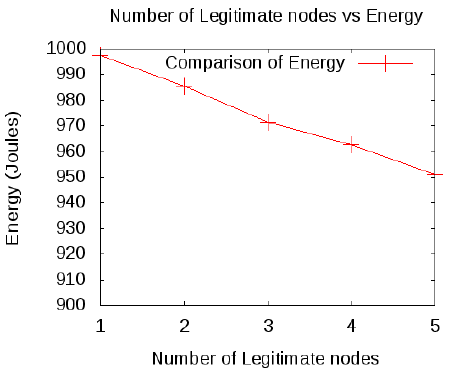
Figure 8. Energy in the absence of spoofing attack.